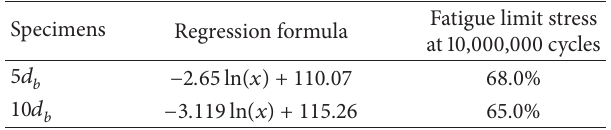
Table 3: Estimation of fatigue limit stress based on a regression analysis.